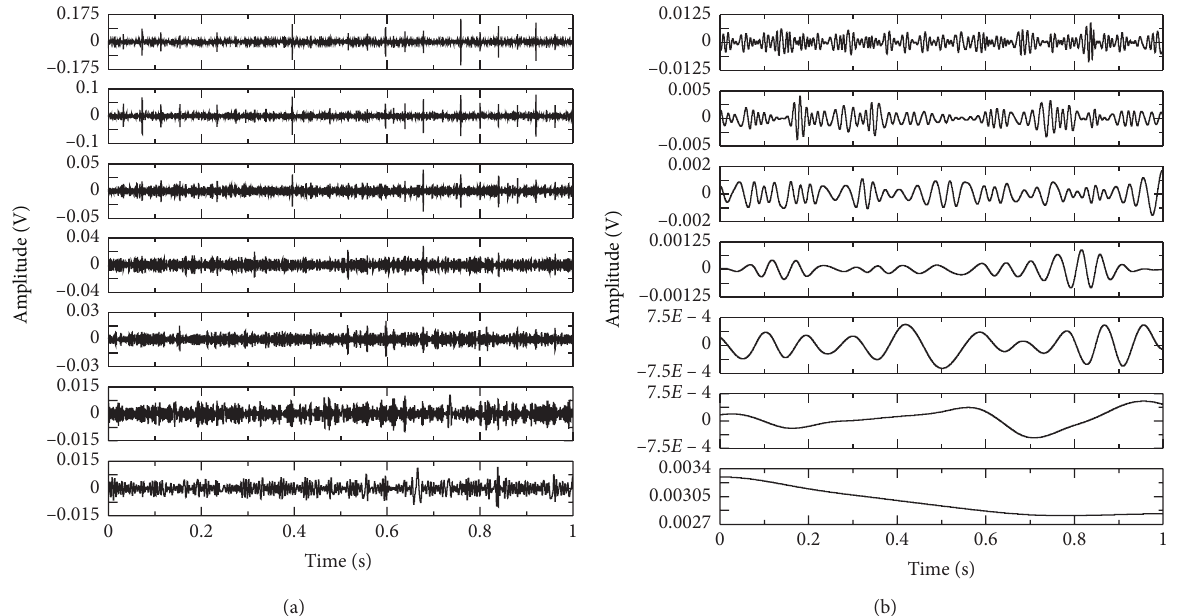
Figure 15: Vibration signals of EEMD diagrams. (a) IMFs 1–7. (b) IMFs